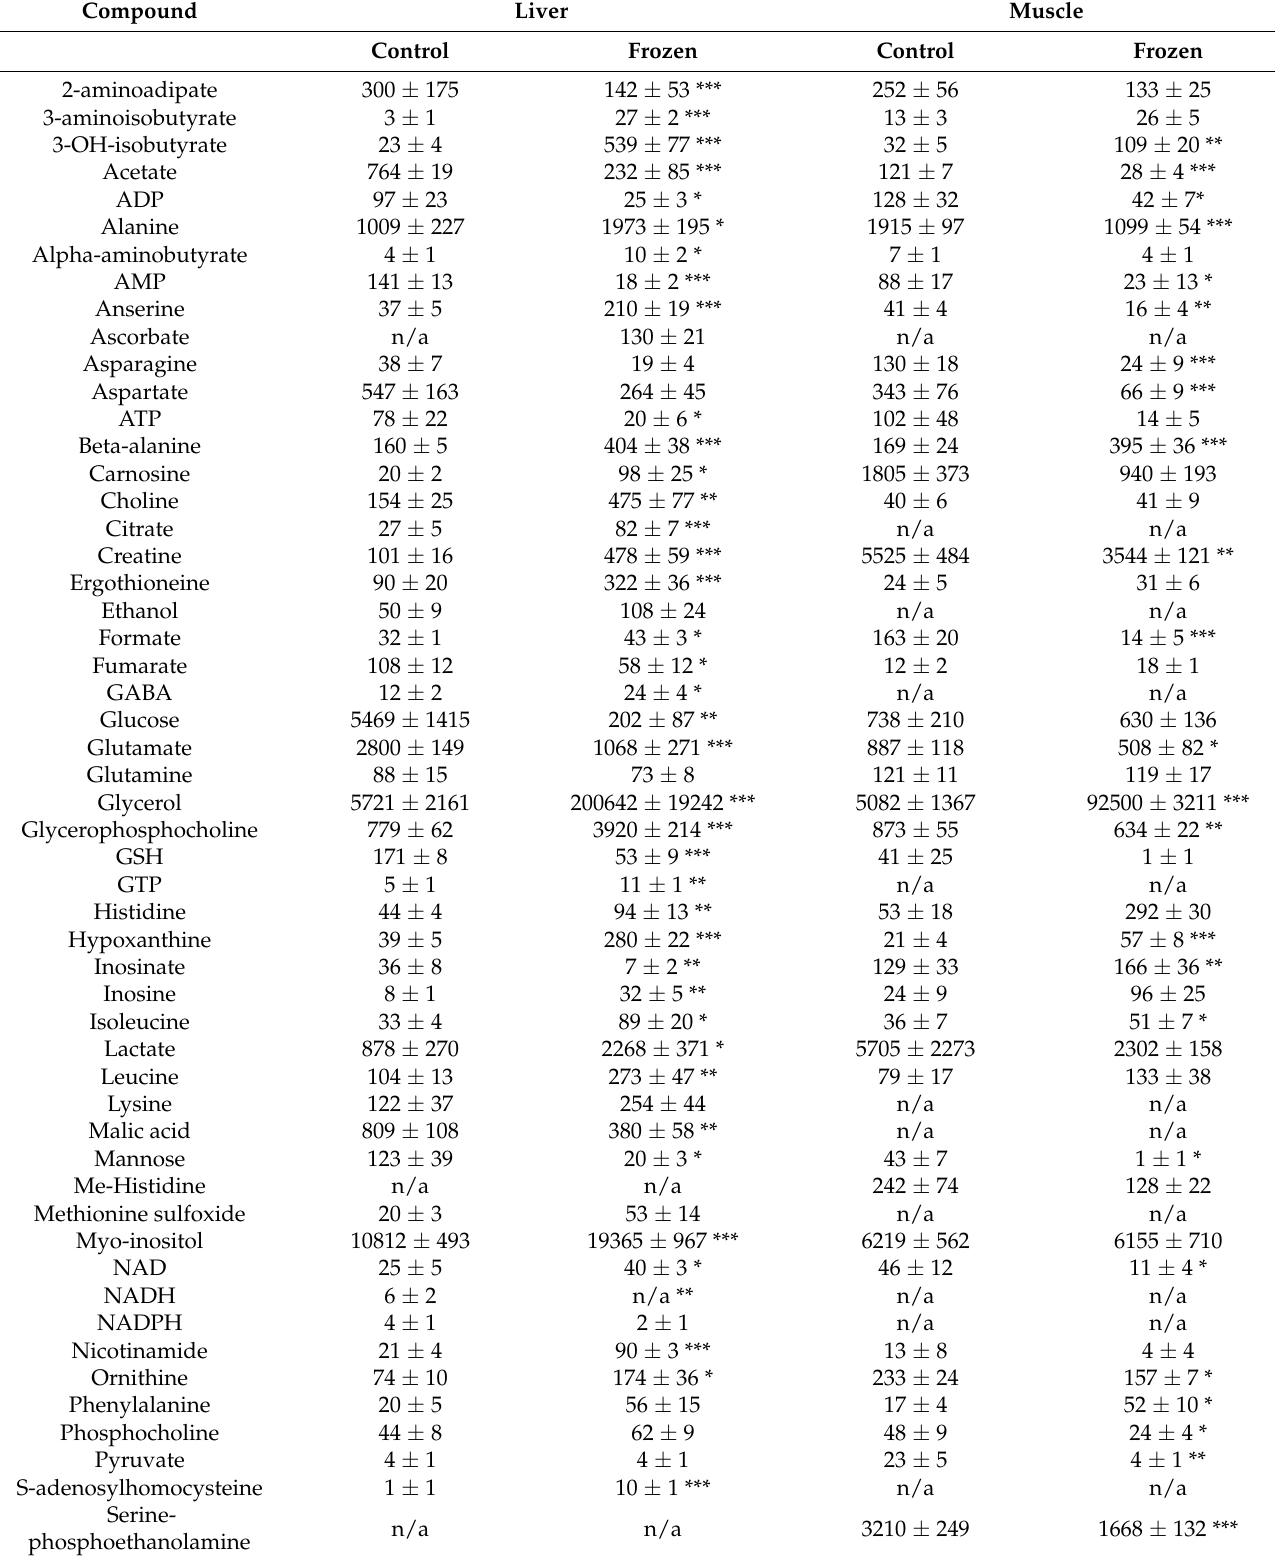
Table 2. Average concentrations of the detected metabolites in the organs of S. keyserlingii (nmoles per gram of wet tissue) ± standard error ( n = 5); n/a, not detected. Statistical significance between frozen and control samples: * Welch test p < 0.05; ** p < 0.01; *** p <